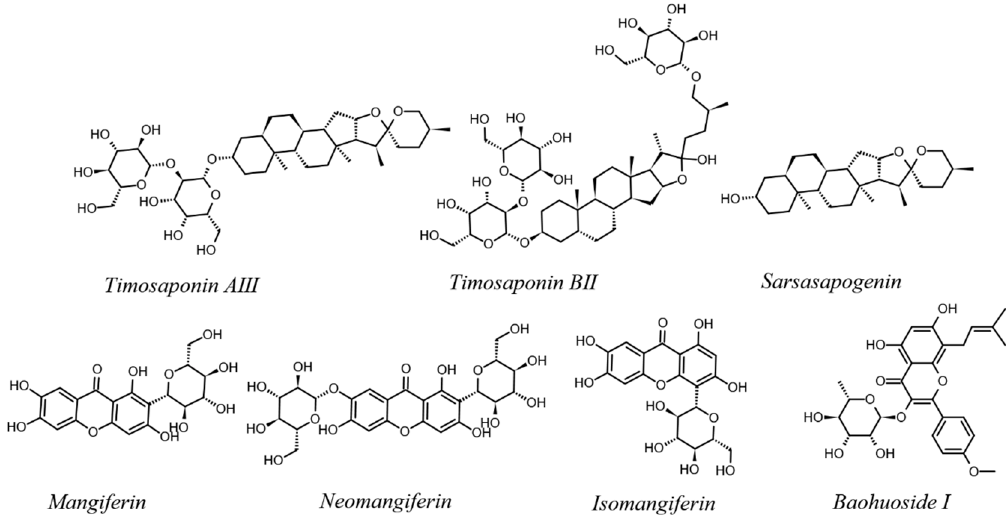
Figure 1. Chemical structures of seven compounds in AR.